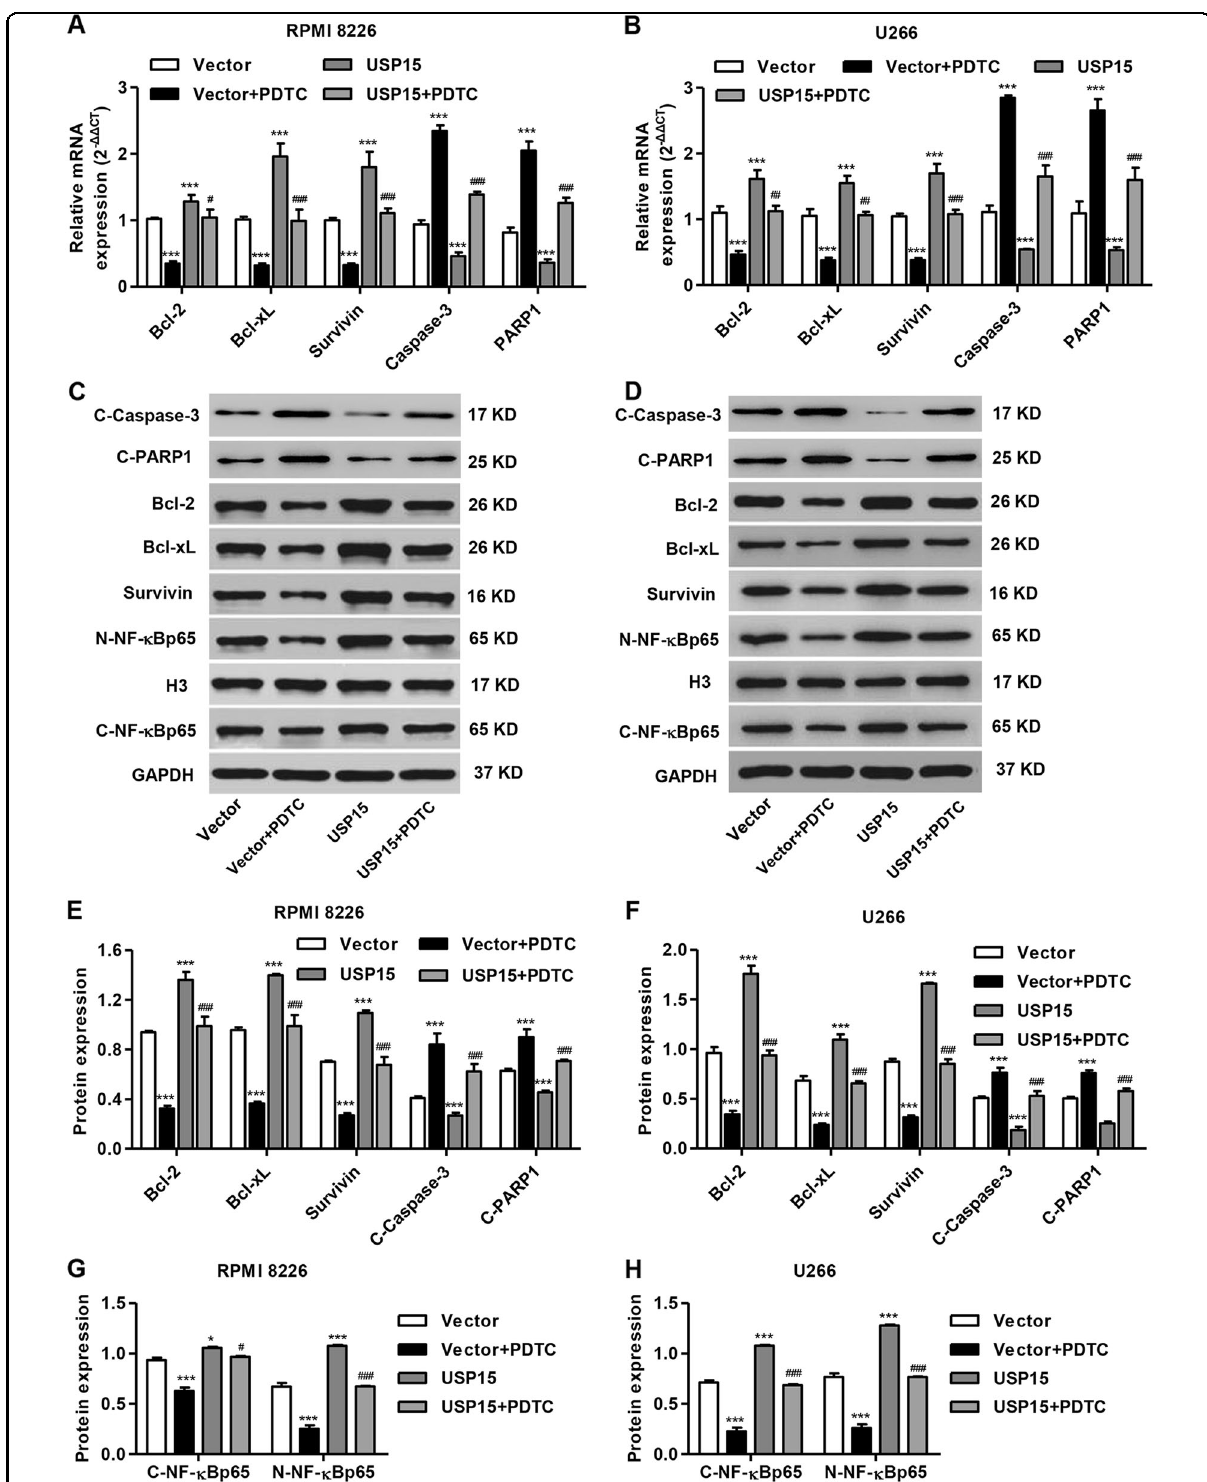
Fig. 7 PDTC treatment inhibits USP15 overexpression-induced expression of Bcl-2, Bcl-xL, Survivin and NF- κ Bp65 in MM cells. After RPMI 8226 and U266 cells cultured in complete medium containing either PDTC (50 μ M) or no inhibitor were transfected with pLVX-Puro-USP15, the expression of Bcl-2, Bcl-xL, Survivin, cleaved Caspase-3 (C-Caspase-3), cleaved PARP1 (C-PARP1), nuclear NF- κ Bp65, and cytoplasmic NF- κ Bp65 was measured by Real-time PCR ( a , b ) and/or western blot ( c - h ). * P < 0.05, *** P < 0.001 compared with vector. # P < 0.05; ## P < 0.01; ### P < 0.001 compared with